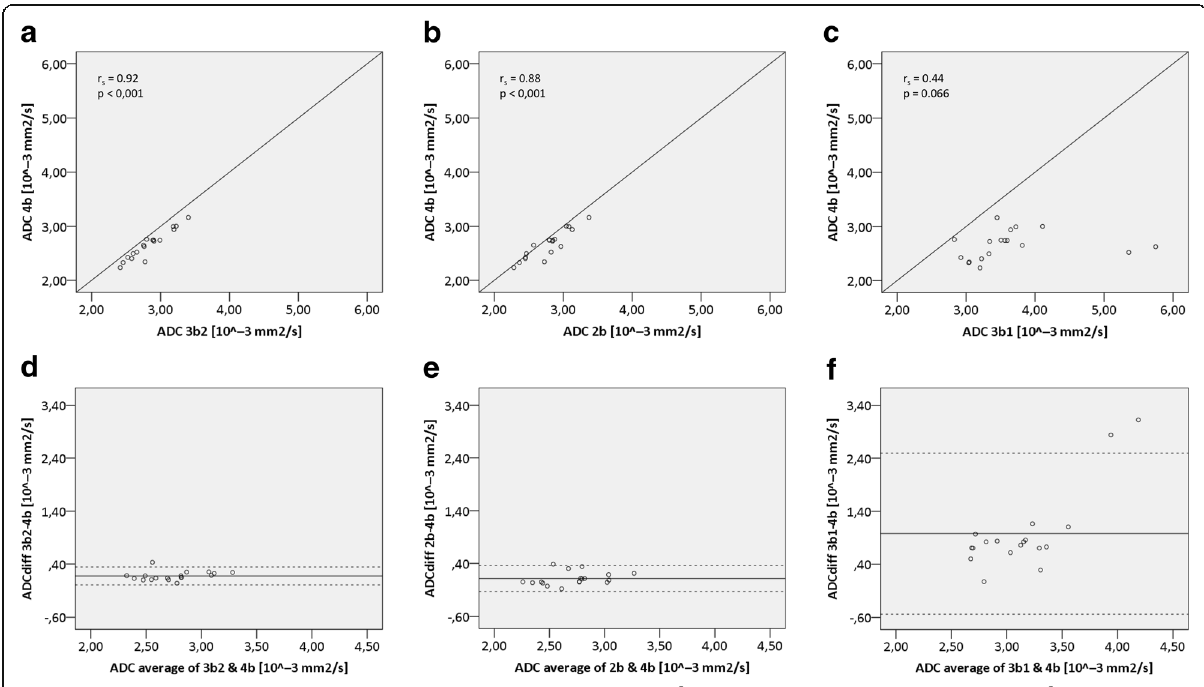
Fig. 2 a – c Correlation plots of measurements using 4b ( b = 0, 100, 200, 300 s/mm 2 ) plotted against a 3b2 ( b = 0, 200, 300 s/mm 2 ), b 3b1 ( b = 0,100, 200 s/mm 2 ), and c 2b ( b = 0, 300 s/mm 2 ). r s = spearman ’ s rank correlation coefficient. d – f Bland-Altman-Plots showing the differences between ADC measurements plotted against their corresponding average with 95% limits of agreement (dotted